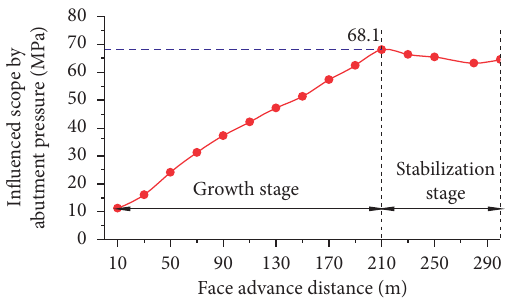
Figure 4: Diagram of abutment pressure influence range with working face